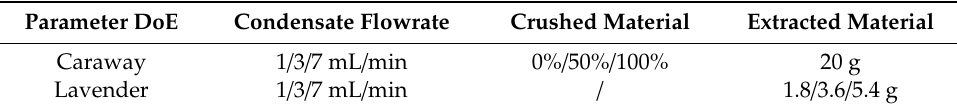
Table 3. Summary of experimental